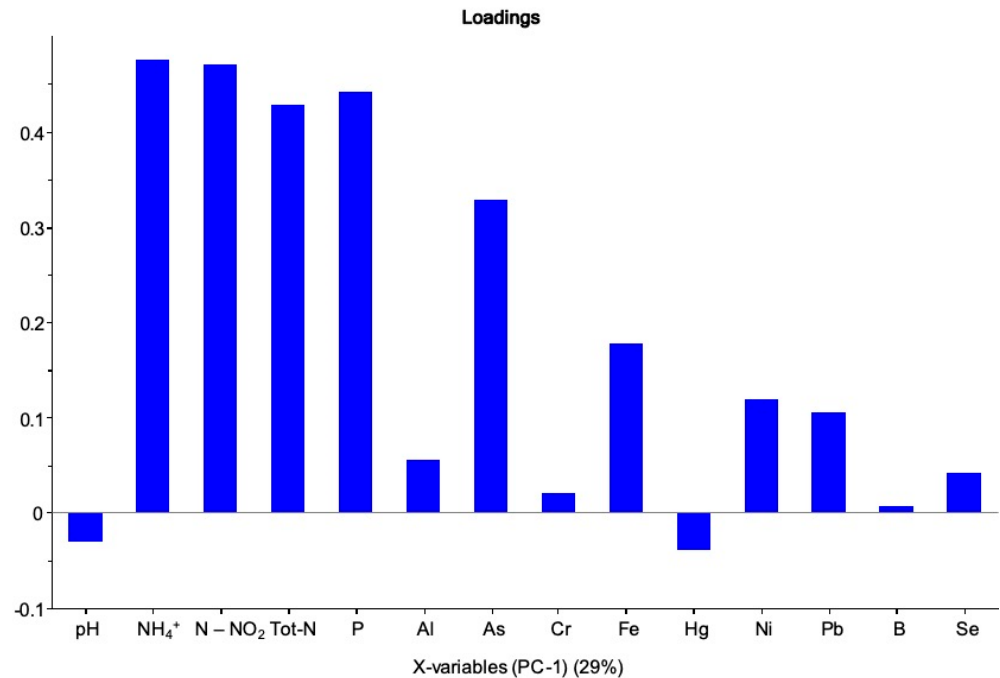
Figure 2. Loadings bar plot.